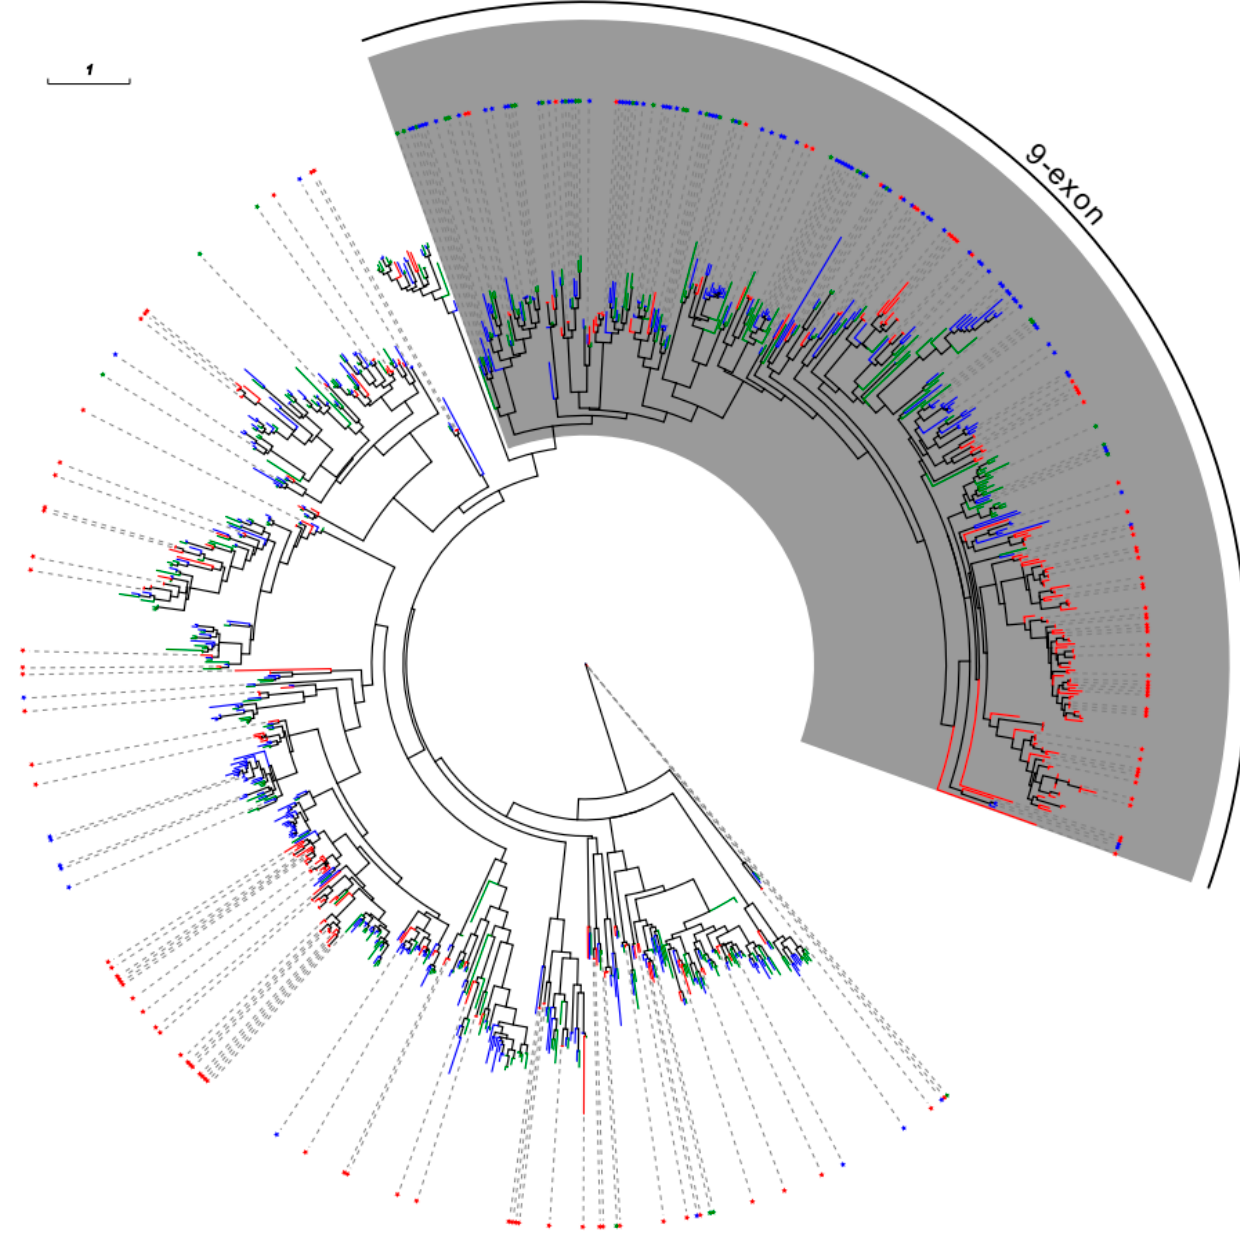
Figure 4. Phylogenetic tree of ORs in three Formicidae species. ORs in S. invicta are labeled in blue, those in O. biroi are labeled in red, in those in M. pharaonis are labeled in green. The shaded clade is an expanded clade of the 9-exon OR subfamily. The blue star indicates the 9-exon ORs of S. invicta , the red star indicates the 9-exon ORs of O. biroi , and the green star indicates the 9-exon ORs of M. pharaonis .